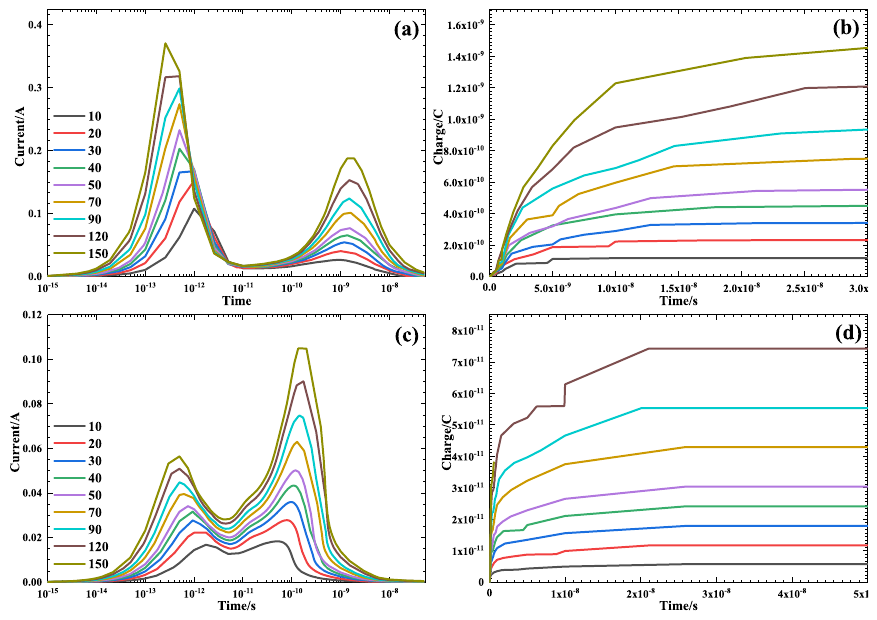
Figure 9. Change in collector current and collected charge with time when heavy ions with different LET values vertically irradiate the collector ( a , b ) and substrate ( c , d ) of the SiGe